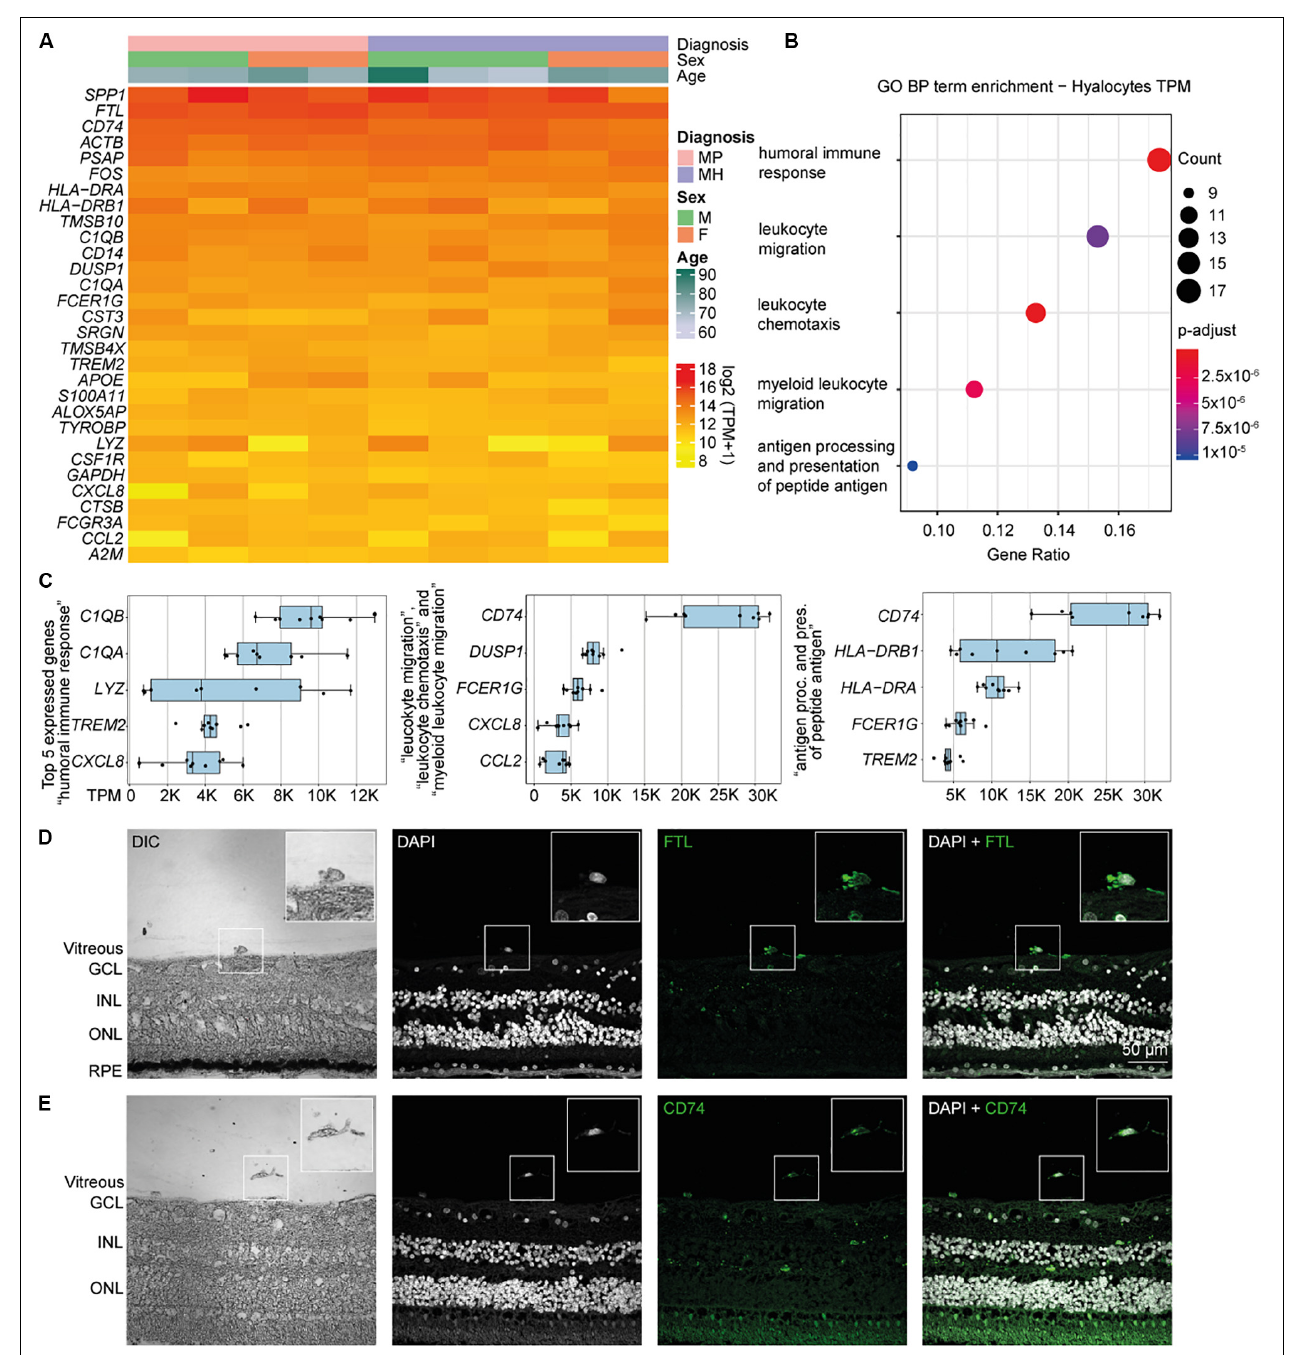
FIGURE 2 | High throughput sequencing characterization of human hyalocytes. (A) Heatmap of the most prominent transcripts in human hyalocytes sorted by transcripts per million (TPM). The color bars on the top of the heatmap reveal diagnosis of study subjects (pink for macular pucker, lilac for macular hole), sex (grass-green for male, orange for female), and age (age scale bar legend to the right). (B) Most significant Gene ontology biological process (BP) clusters of the 100 most highly expressed mRNA transcripts in hyalocytes. Color coding of the dots according to the p -adjusted value, size of the dots according to the count of transcripts associated with the respective GO term. (C) Top five most highly expressed transcripts in the five enriched GO terms in B . (D) Immunohistochemical staining for FTL. Higher magnification of a vitreal cell is presented in the upper right corner. Nuclei are counterstained with DAPI (4’,6-Diamidin-2-phenylindol). DIC, differential interference contrast; GCL, ganglion cell layer; INL, inner nuclear layer; ONL, outer nuclear layer; and RPE, retinal pigment epithelium. (E) Immunohistochemical staining for CD74. Higher magnification of a vitreal cell is presented in the upper right corner. Nuclei are counterstained with DAPI (4’,6-Diamidin-2-phenylindol). DIC, differential interference contrast; GCL, ganglion cell layer; INL, inner nuclear layer; and ONL, outer nuclear layer.